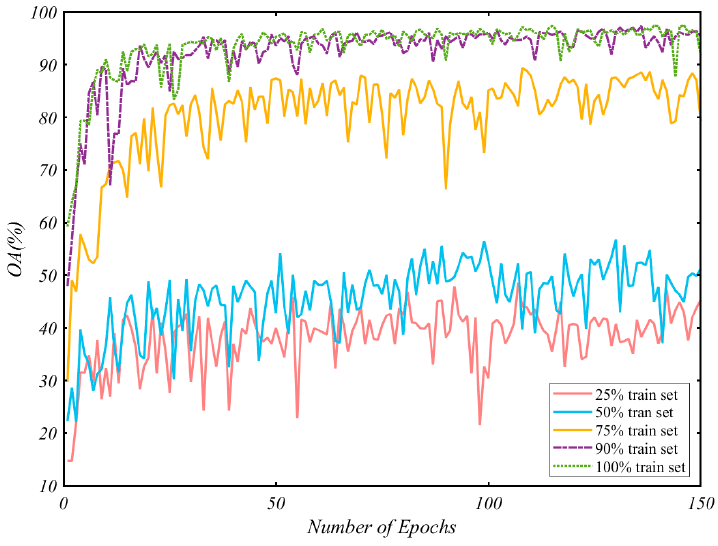
Figure 17. The overall accuracy varying with the number of epochs.